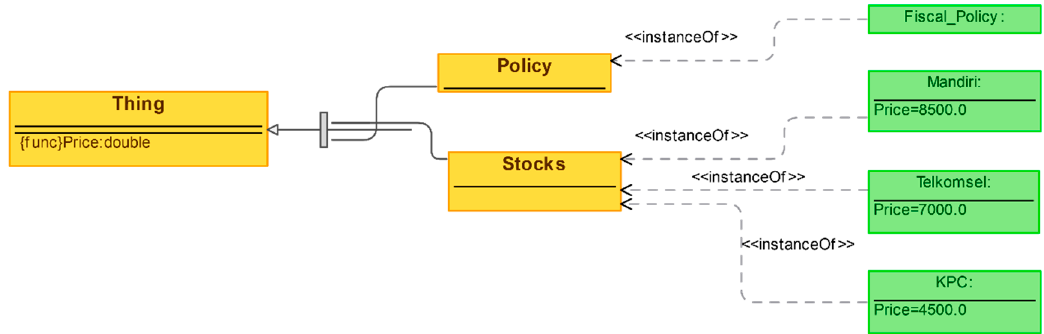
Figure 3. Investment − The structure of classes and individuals in the OWL document. Information 2018 , 9 , x FOR PEER REVIEW